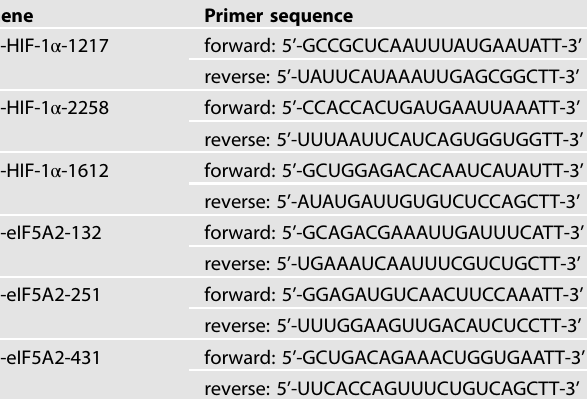
Table 2. Primers utilized for qRT-PCR in this study. Table 1. Primers utilized for transfection in this